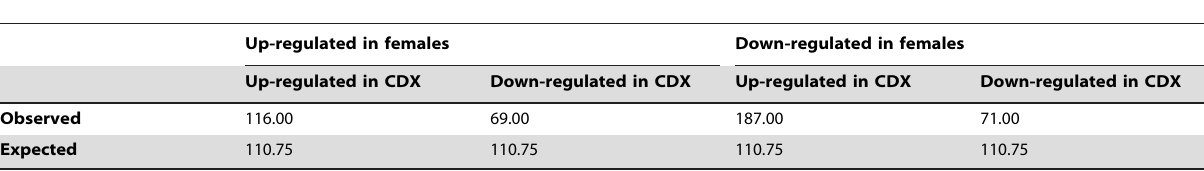
Table 2. Results of test for feminization of X-linked transcripts in CDX